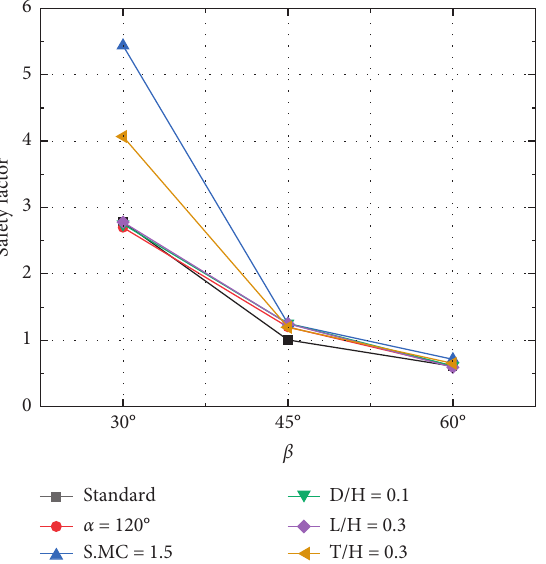
Figure 8: The influence of slope angle on slope stability.